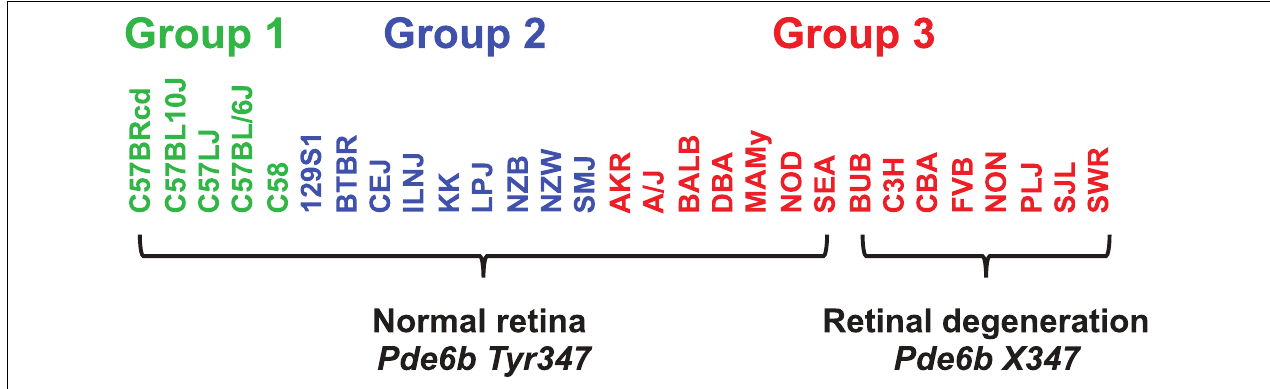
FIGURE 4 | The haplotype block with a causative mutation is associated with population structure. MPD 26721 examined the retinas of 29 inbred strains: 21 strains had normal retinas and 8 strains had retinal degeneration. A haplotype block within Pde6b contained the causative SNP ( Tyr347X ) for this type of retinal degeneration. All strains with retinal degeneration had the Pde6b 347X allele, while those with normal retinas had the Tyr347 allele. The haplotype block had PS, because all group 1 and 2 strains [based upon hierarchical clustering of whole genome sequence data from 49 inbred strains ( Table 1 )] had normal retinas; while all strains with retinal degeneration were group 3 strains. However, several group 3 strains (AKR, A/J, BALB, DBA, MAMy, NOD, SEA) had normal retinas and the Tyr347 allele. Thus, while the strain groupings within the block have PS based upon their global allele sharing pattern, the allelic pattern within the haplotype block had a stronger association with retinal